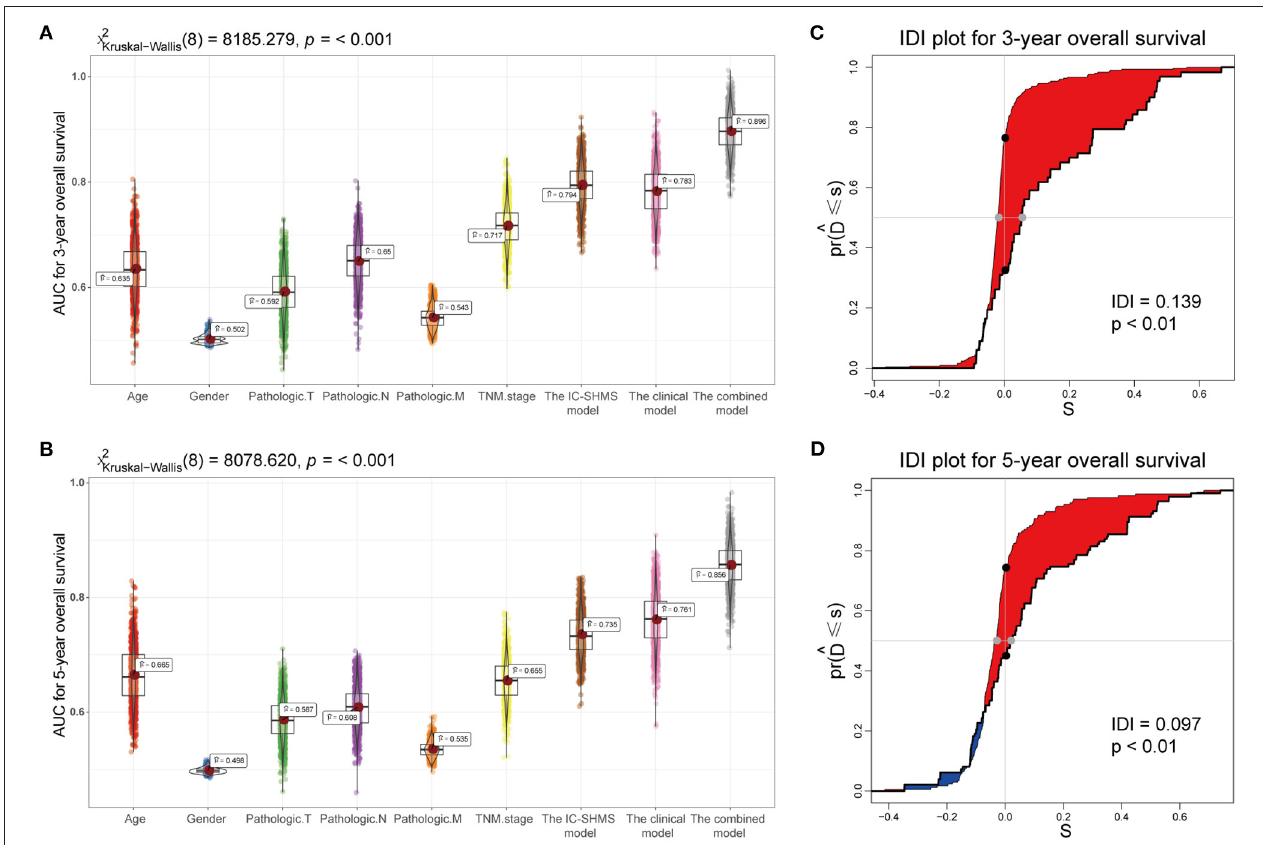
FIGURE 8 | Comparison of the predictive accuracy of the IC-SHMS, clinical, and combined models. (A,B) Box plot showing the prediction accuracy for 3- and 5-year OS, based on the AUC with 1,000 × bootstrap resampling. (C,D) IDI charts showing that, compared with the clinical model, the combined model with nine additional IC-SHMSs improved the prediction accuracy of 3- and 5-year OS in a statistically significant manner ( p <